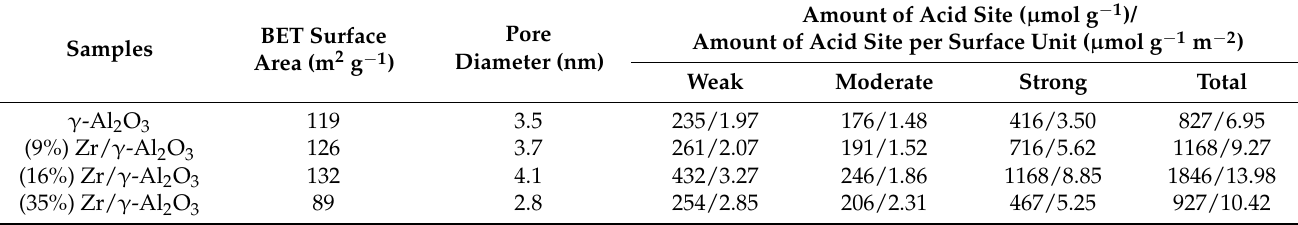
Table 2. Specific surface area, pore diameter, NH 3 -TPD acidic sites and amount of acidic site per surface unit results for the catalyst.